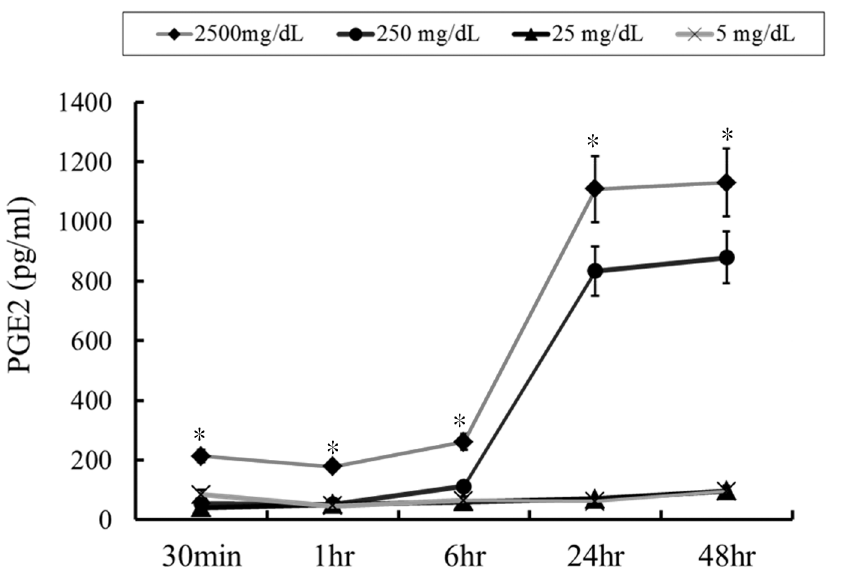
separately carried out three times each (N = 4).